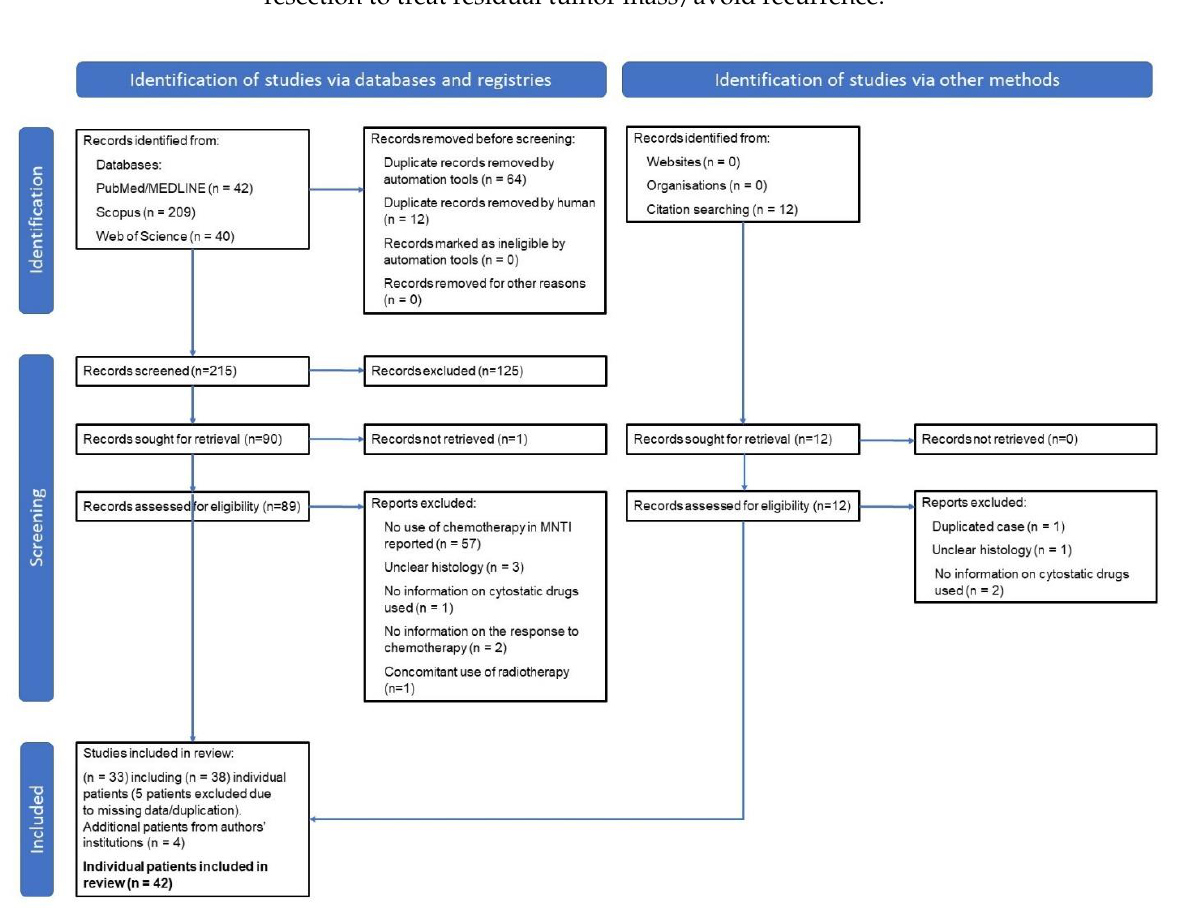
Table 5. Demographic and clinical data of the analyzed patients.